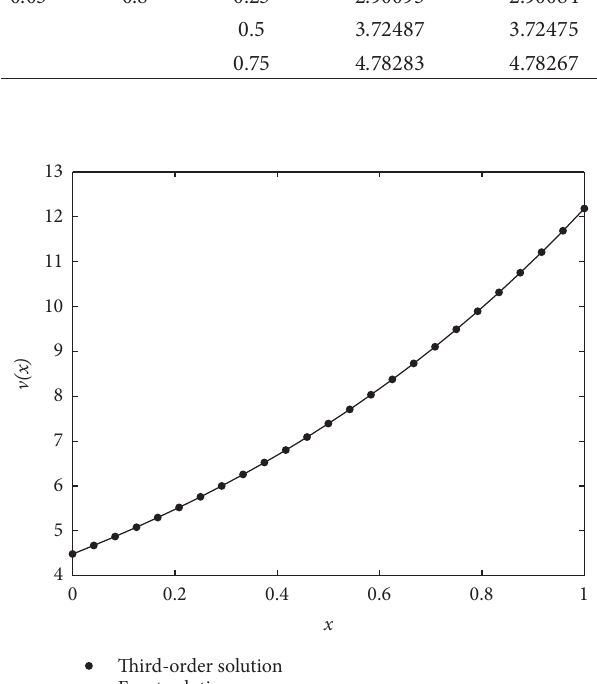
Figure 6: Convergence of third-order solution of V (𝑥,𝑦, 𝑡) at 𝑡 = 𝑦 = 1 . solutions for fractional equations converge. Results